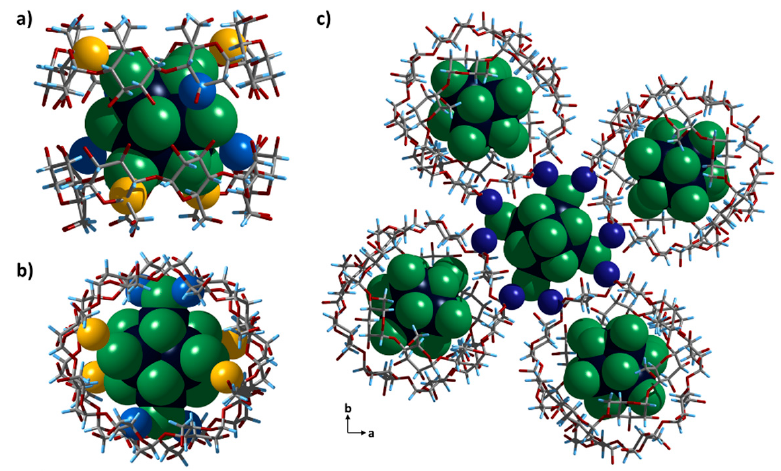
Figure 2. Selected fragments of crystal structure of W 6 Cl 14 @2CD·0.5W 6 Cl 14 . Side ( a ) and top ( b ) view of inclusion compound {[W 6 Cl i8 Cl a6 ]@( γ -CD) 2 } 2– . Highlight of the packing involving CD-free clusters and its four neighboring moieties. ( c ). W—dark blue, Cl—green, O—red, C—gray, H—light blue,